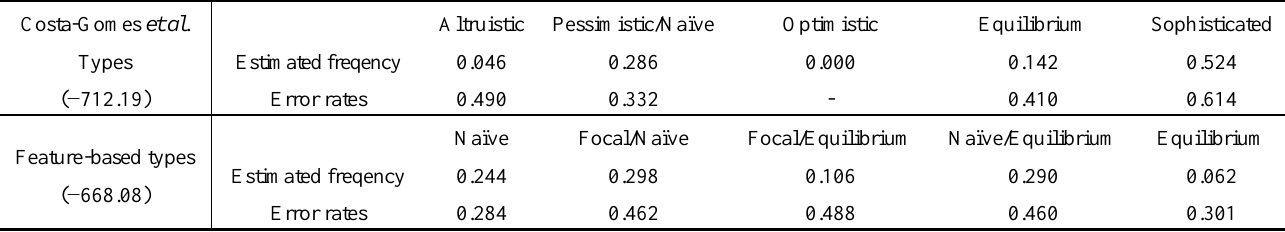
Table 7. Parameters estimated using Costa-Gomes et al . types and with feature-based types. Log-likelihood in